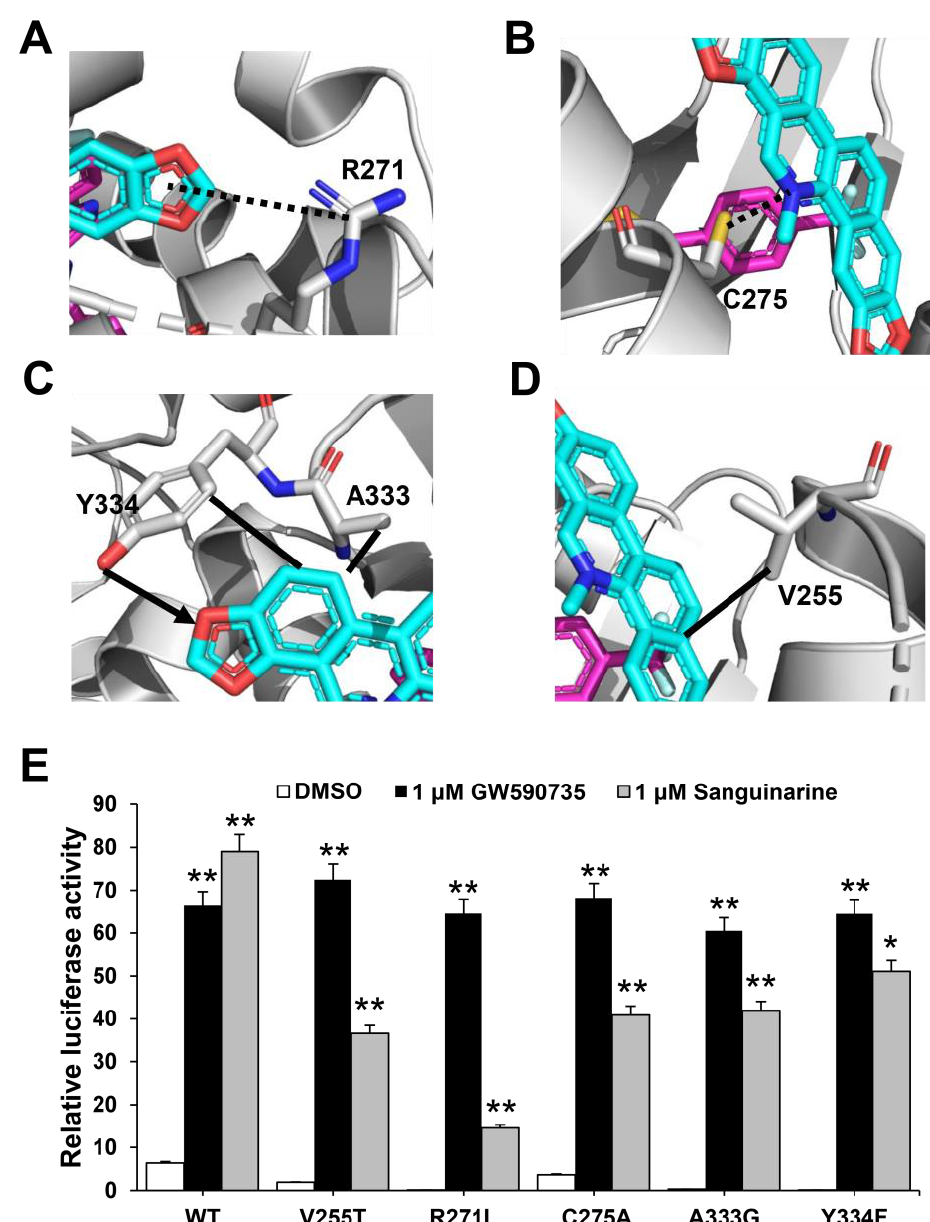
Figure 5. Functional correlation of the sanguinarine–PPAR α interactions. ( A – D ) Molecular determi- nants of the interactions between sanguinarine ligand with PPAR α . The bound sanguinarine is shown in stick representation, with carbon and oxygen atoms depicted in cyan and red, respectively. The PPAR α ligand, GW735, resulted from superposition and is shown in stick representation with carbon, nitrogen, and oxygen atoms depicted in magenta, blue, and red, respectively. The hydrophobic interactions and hydrogen bonds are shown with lines and arrows, and the potential hydrogen bonds are indicated by dashed lines. ( E ) Effects of mutations of key PPAR α residues on their transcriptional activity in response to sanguinarine treatment in cell-based reporter gene assays. 293T cells were co-transfected with plasmids encoding PPAR α –LBD–WT or mutants, as indicated in the figures fused with the GAL4–DNA-binding domain together with the pG5Luc reporter. The cells were treated with 1 µ M sanguinarine and 1 µ M GW590735, respectively. The results equate to the average of experiments performed in triplicate, with error bars indicating SDs; * p < 0.05, ** p < 0.01, compared with